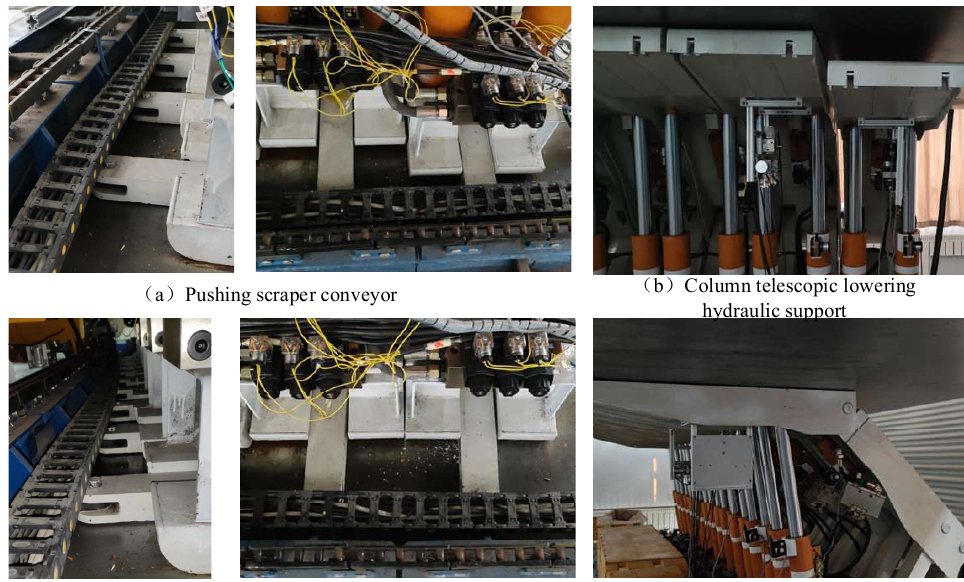
Figure 27. Autonomous following experiment of hydraulic support. (a) shows pushing scraper conveyor. (b) shows column telescopic lowering hydraulic support. (c) shows drag hydraulic sup- port of scraper conveyor. (d) shows adjust the position and posture of the hydraulic support and complete automatic machine following